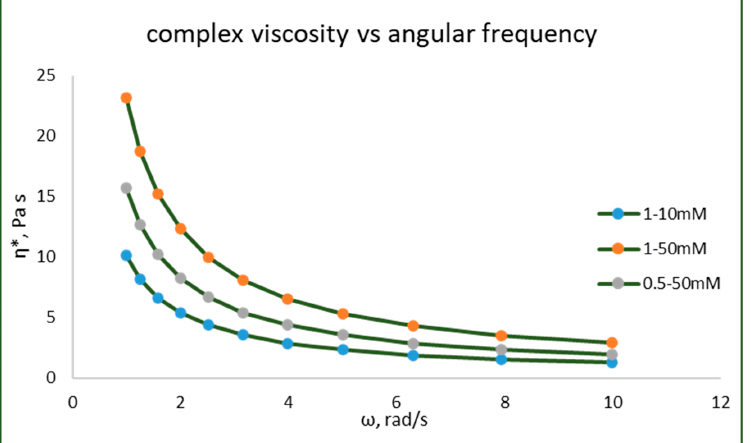
Figure 10. Frequency sweep ( ω ) and complex viscosity ( η ) of hydrogels at different concentrations. (See Supplementary Tables